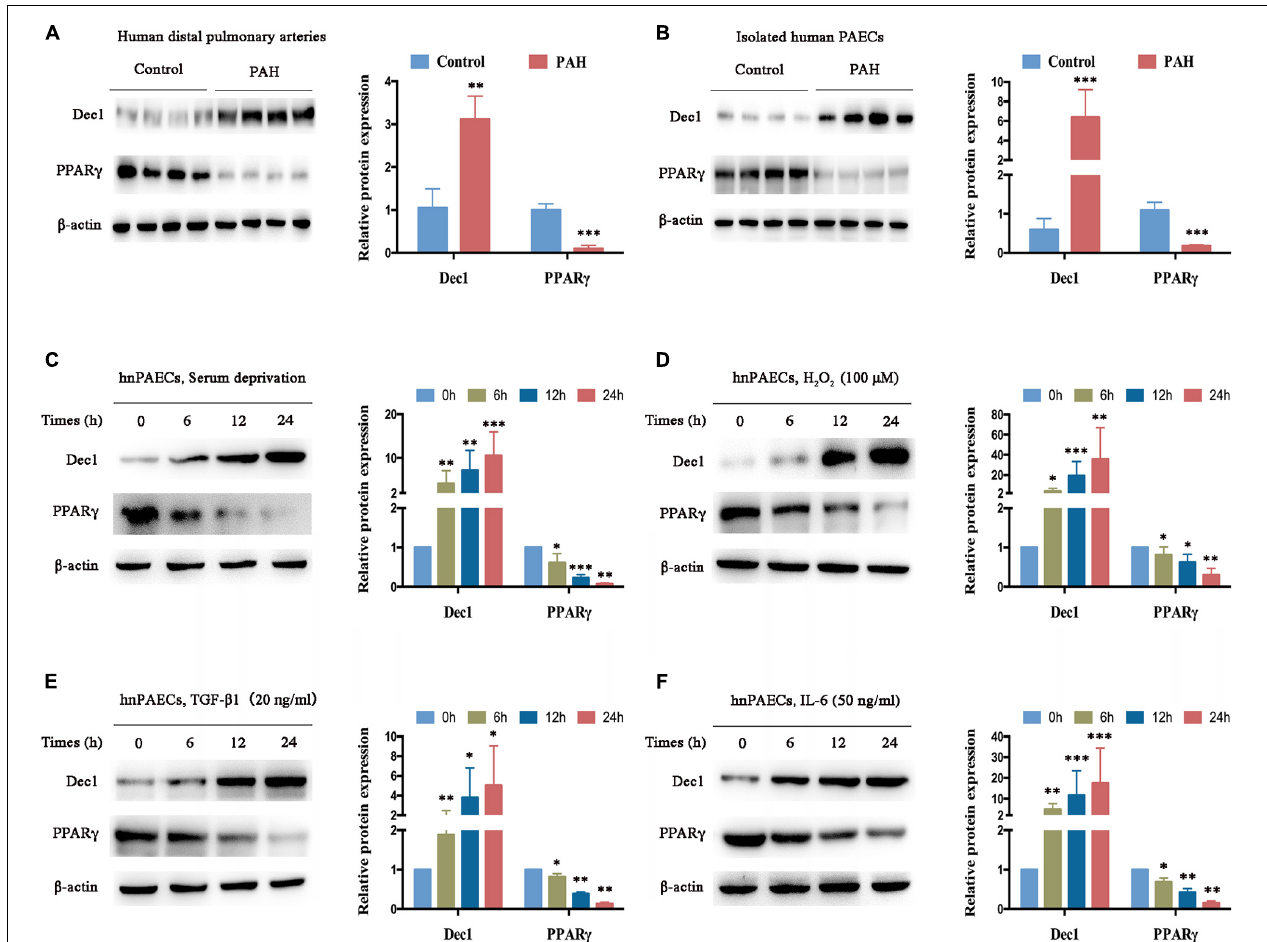
FIGURE 2 | Dec1 is upregulated and PPAR γ is downregulated in PAH. (A) Expression levels of Dec1 and PPAR γ were determined by western blot in pulmonary arteries from PAH ( n = 4) and healthy control patients ( n = 4). (B) Human pulmonary arterial endothelial cells (PAECs) were isolated from PAH and healthy control patients ( n = 4 per group), and western blot was performed to determine expressions of the Dec1–PPAR γ axis. (C–F) Human normal PAECs (hnPAECs) were treated with serum deprivation (C) , 100 µ M H 2 O 2 (D) , 20 ng/ml TGF- β 1 (E) , and 50 ng/ml IL-6 (F) in vitro . Expression levels of Dec1 and PPAR γ in PAECs were determined by western blot (left part) at the indicated times. One-way ANOVA test was applied for statistical analysis (right part). Data are represented as mean ± SEM. Experiments were repeated for three independent times. ∗ p < 0.05; ∗∗ p < 0.01; ∗∗∗ p <